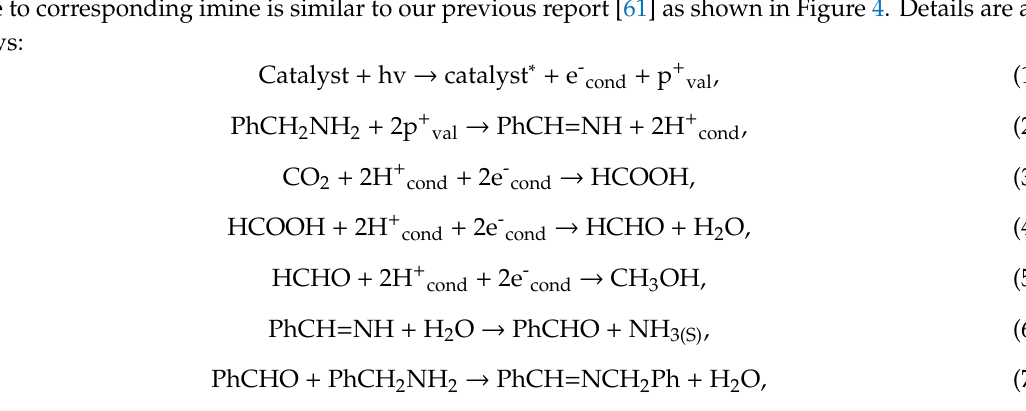
Figure S1. GC chromatograms of (a) before irradiation and (b) the stand CH 3 OH and benzylamine in CH 3 CN and (c) product (CH3OH) after irradiation for 10 h with the partial enlarged drawing. Figure S2. The 1H NMR spectrums of (a) the product (CH 3 OH) photocatalyzed by CuW 0.7 Mo 0.3 O 4 (x = 0.7) after reaction for 10 h and (b) the stand CH 3 OH. Figure S3. the MS of Products photocatalyzed by CuW 0.7 Mo 0.3 O 4 (x = 0.7) after irradiation for 10 h. Figure S4. GC chromatograms of gas phase products after irradiation for 10 h. Figure S5. XPS spectra of (a) Cu 2p and (b) W 4f of